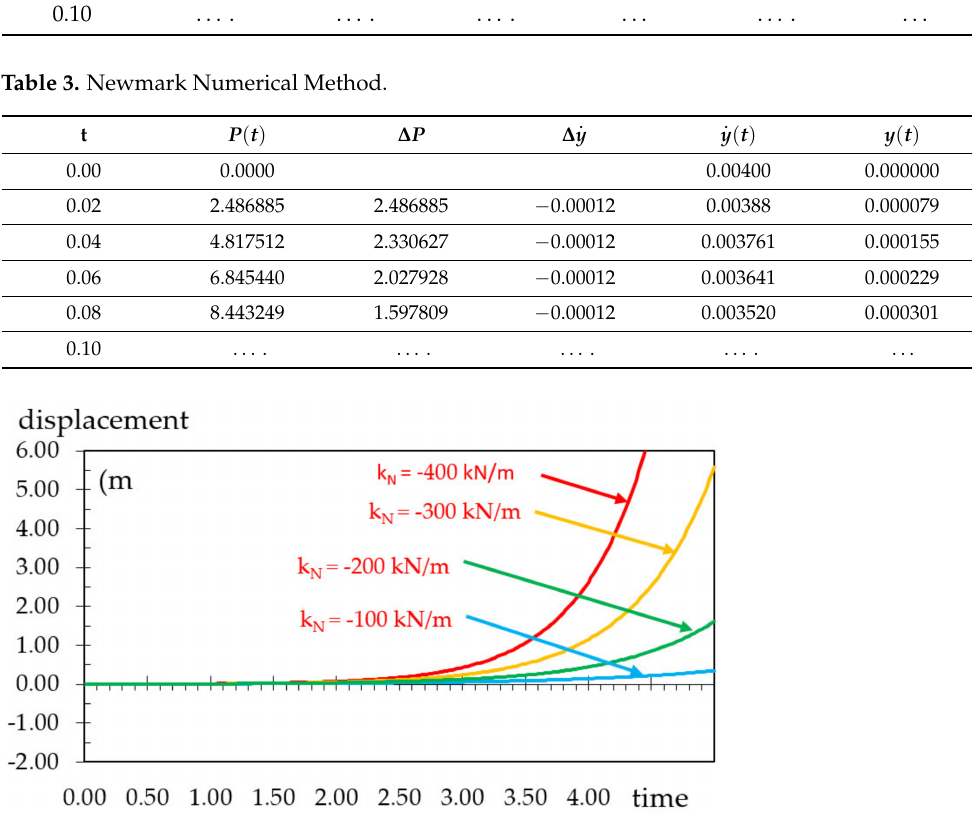
Figure 6. Response displacements of SDoF oscillators with different values of negative